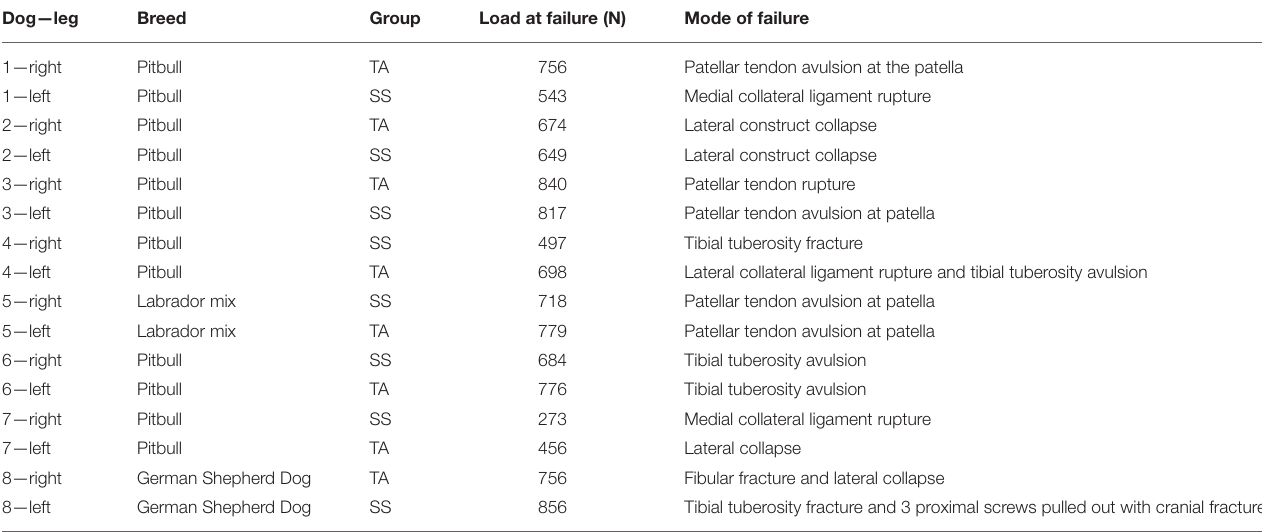
TABLE 1 | Load at failure and modes of failure in paired cadaveric TPLO constructs in the titanium alloy (TA) and stainless steel (SS) groups. Dog—leg